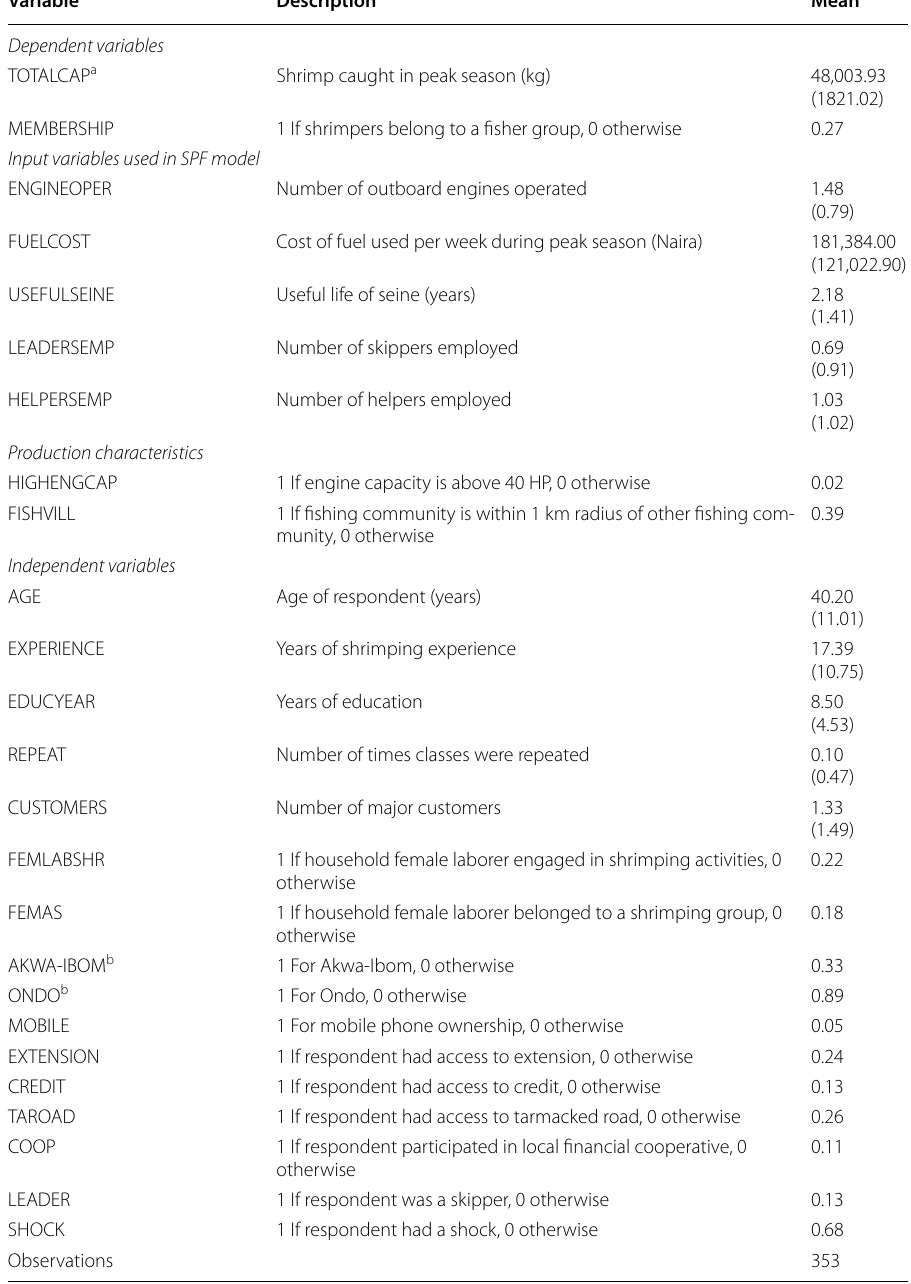
Table 1 Description and summary statistics of key